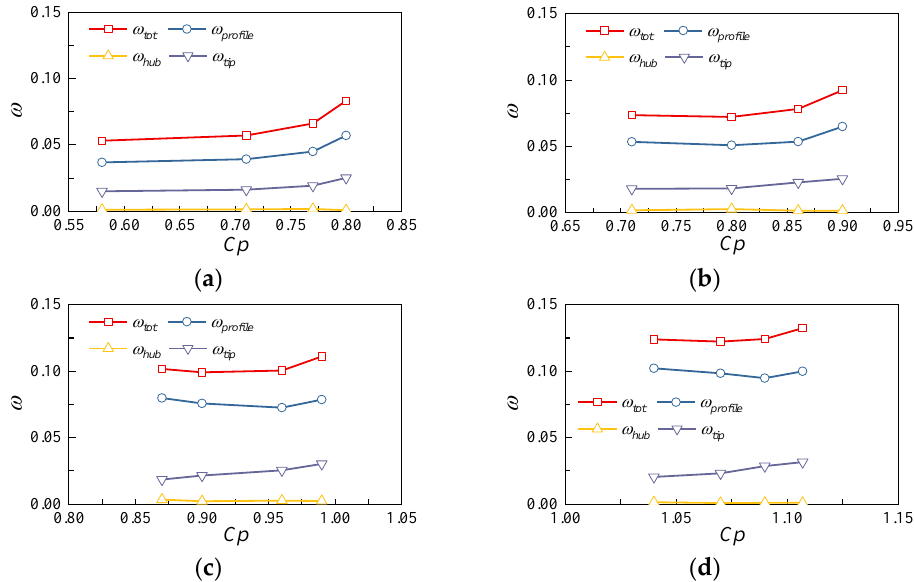
Figure 21. The distribution of pitch-averaged endwall loss for the rotor blade: ( a ) ψ = 0.41; ( b ) ψ = 0.47; ( c ) ψ = 0.55; ( d ) ψ = 0.65.